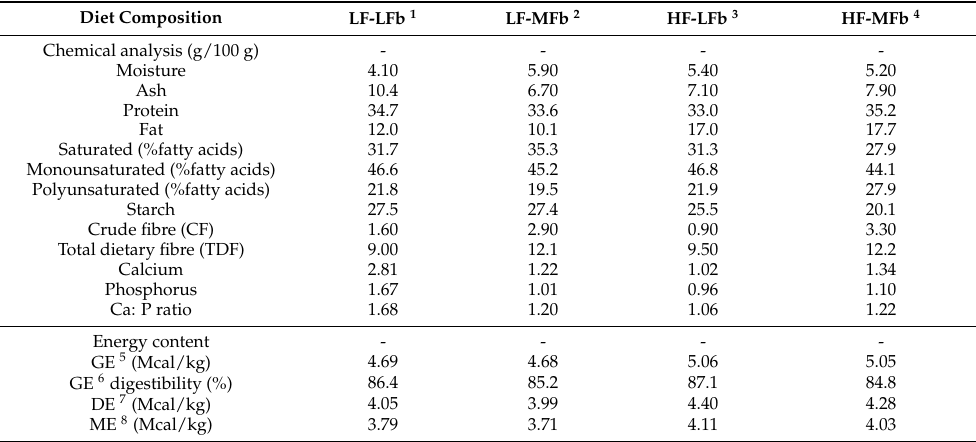
Table 2. Nutrient composition and energy content on as fed basis of the diets used in cats. Diet Composition LF-LFb